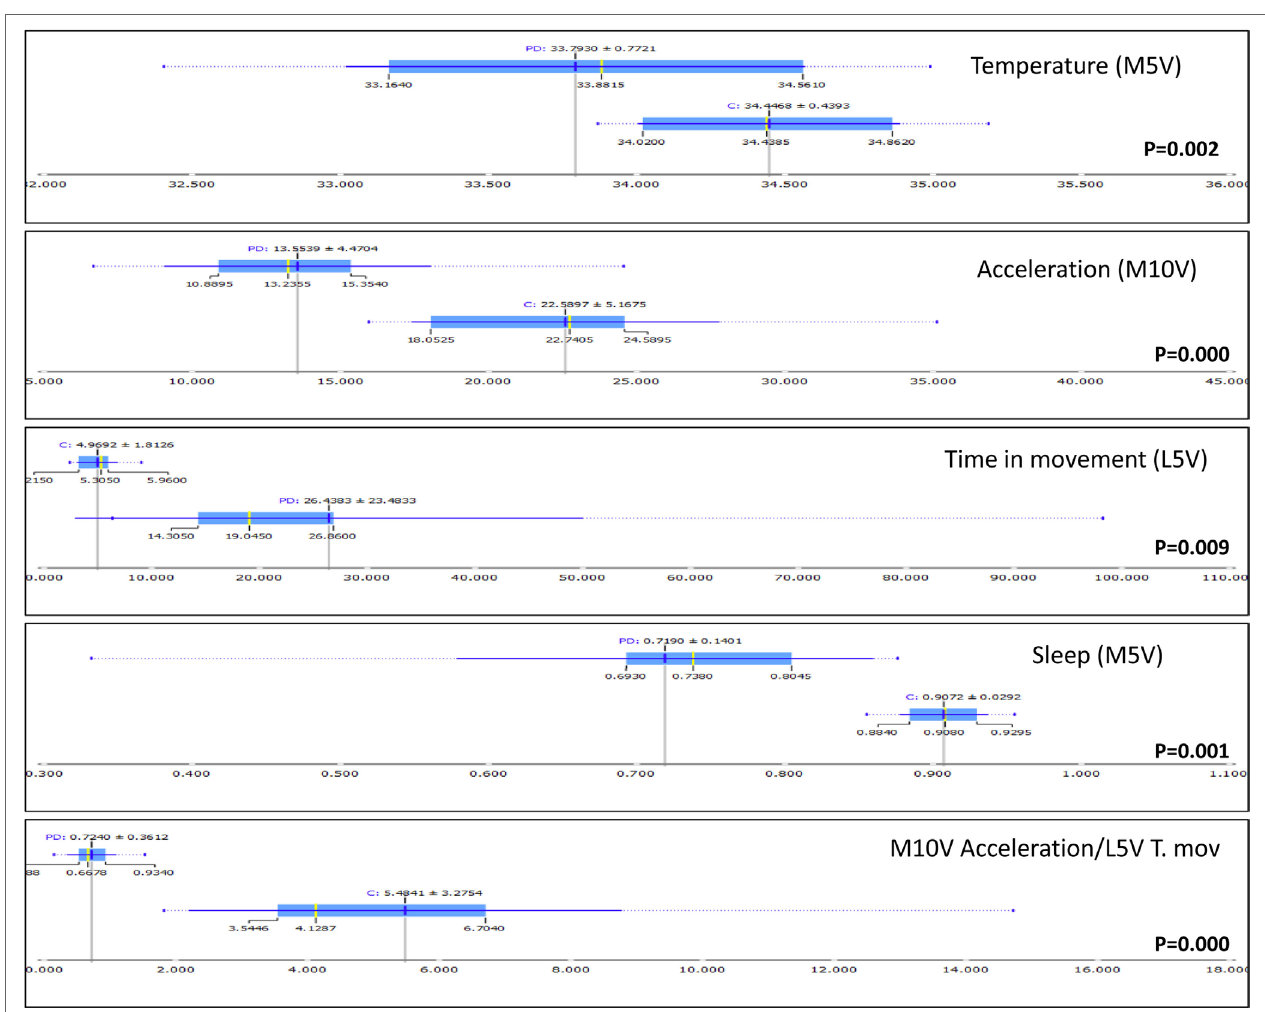
FigUre 4 | Box plot representation of the distribution of most informative attributes selected according to the information gain procedure (Orange Canvas software) from complementary variables of Parkinson’s disease (PD) and healthy controls (C). The mean values are illustrated by the dark blue vertical line. The blue highlighted area indicates the complete SD of the mean, while the median is represented by a gray vertical line. The thin blue line indicates the area between the first (25%) and the third (75%) quartile, while the thin dotted line represents the entire range of values (from the lowest to the highest value in the data set for the selected